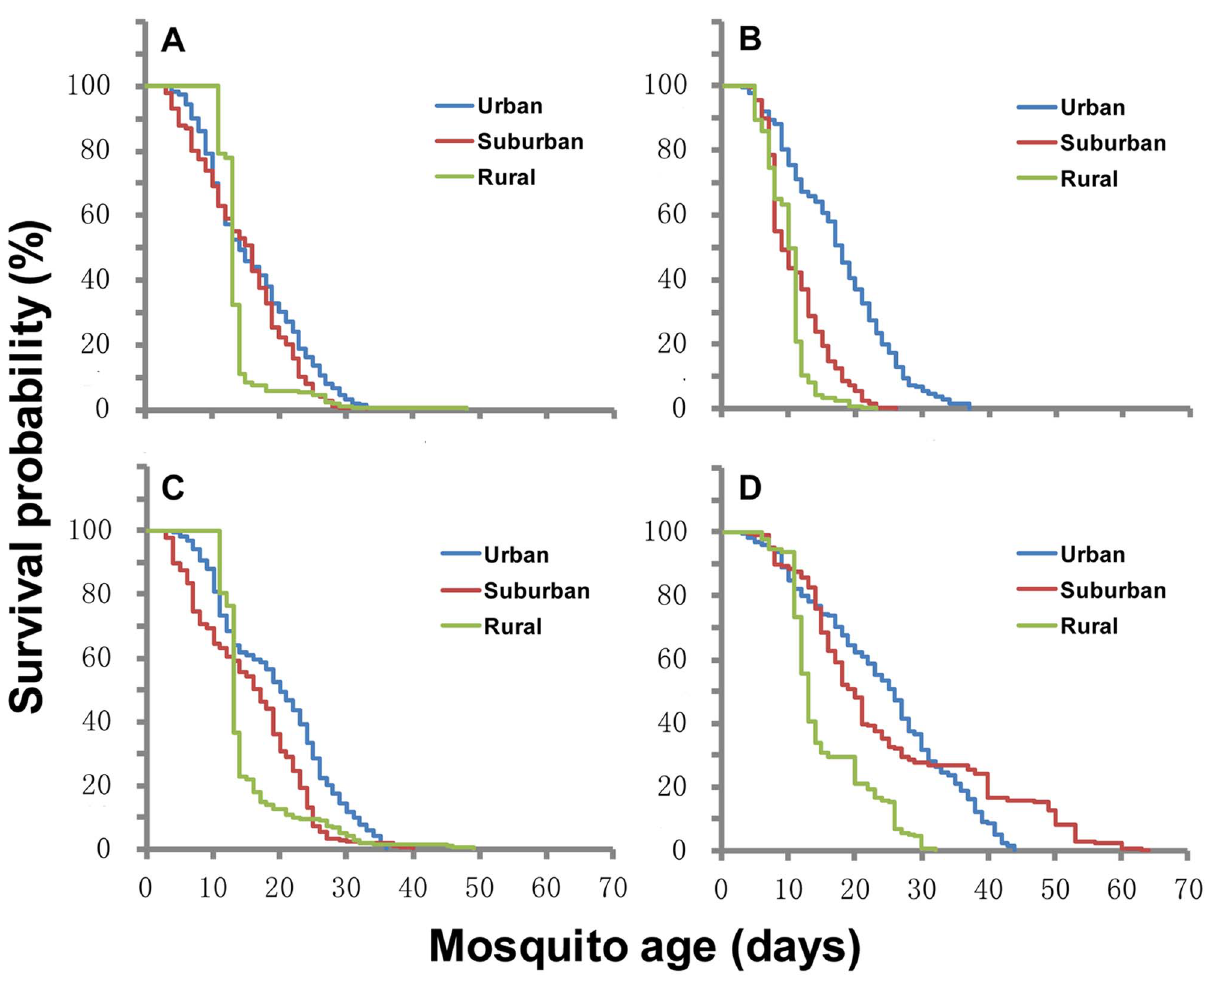
Figure 6. Survivorship curve of adult Aedesalbopictus in different seasons. The left panel is for August to September, and the right panel is for October and November. The top panel (A and B) is for male, and the bottom panel (C and D) is for female.